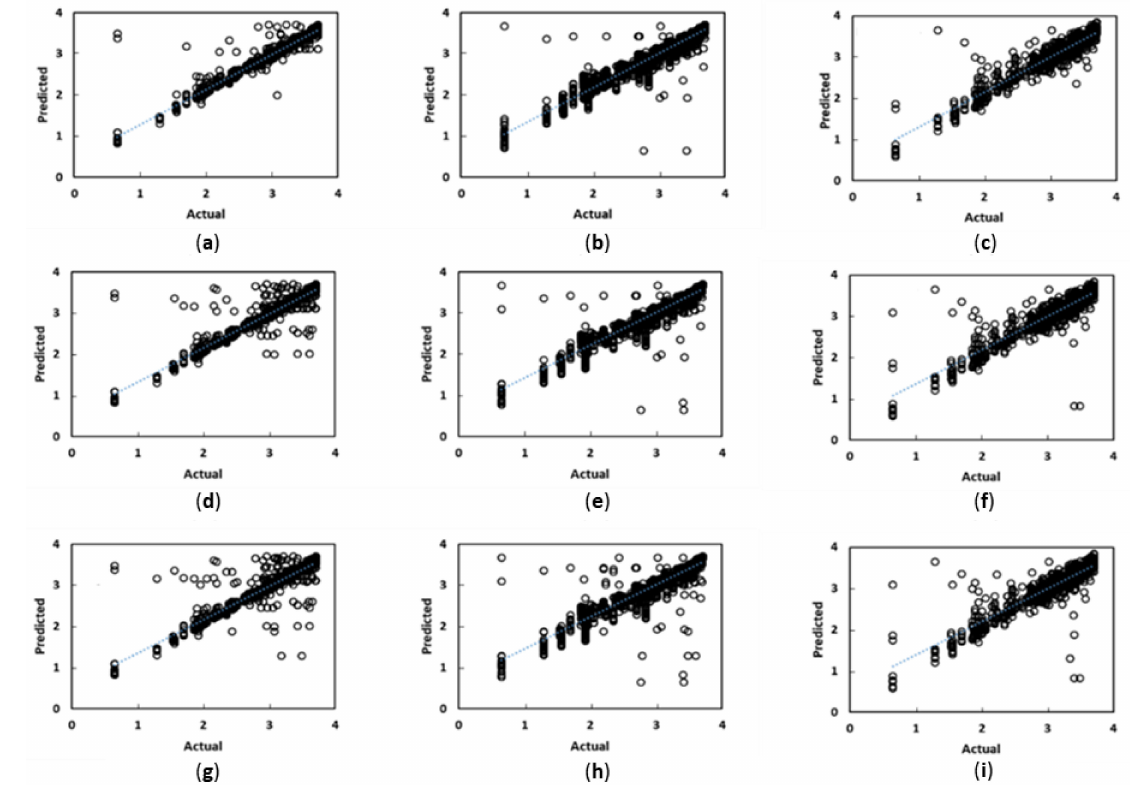
Figure 9. Proxy results charts for CO 2 storage (bscf) where ( a ) Stacked learner with 3500 samples; ( b ) AdaBoost with 3500 samples; ( c ) Random Forest with 3500 samples; ( d ) Stacked learner with 2000 samples; ( e ) AdaBoost with 2000 samples; ( f ) Random Forest with 2000 samples; ( g ) Stacked learner with 1000 samples; ( h ) AdaBoost with 1000 samples; ( i ) Random Forest with 1000 samples. The ordinate refer to the proxy predictions and the abscissa refer to the numerical simulation results.